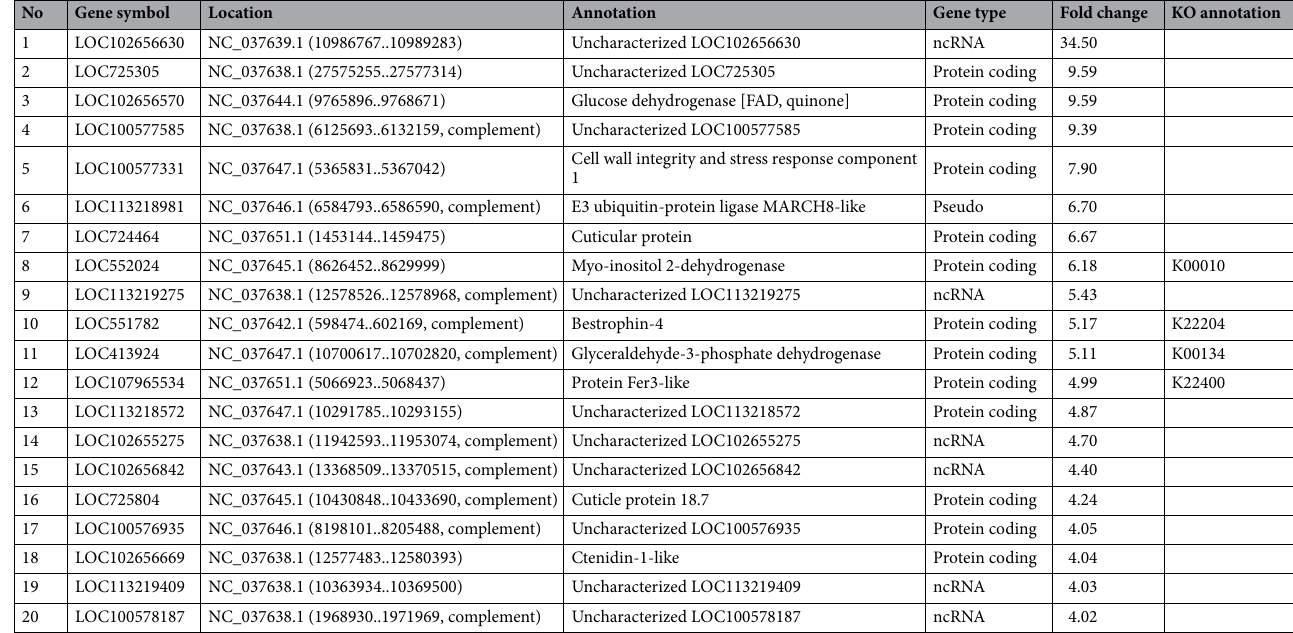
Table 1. List of upregulated genes (fold change ≥ 4) identified in the DWV-infected honey bee larvae